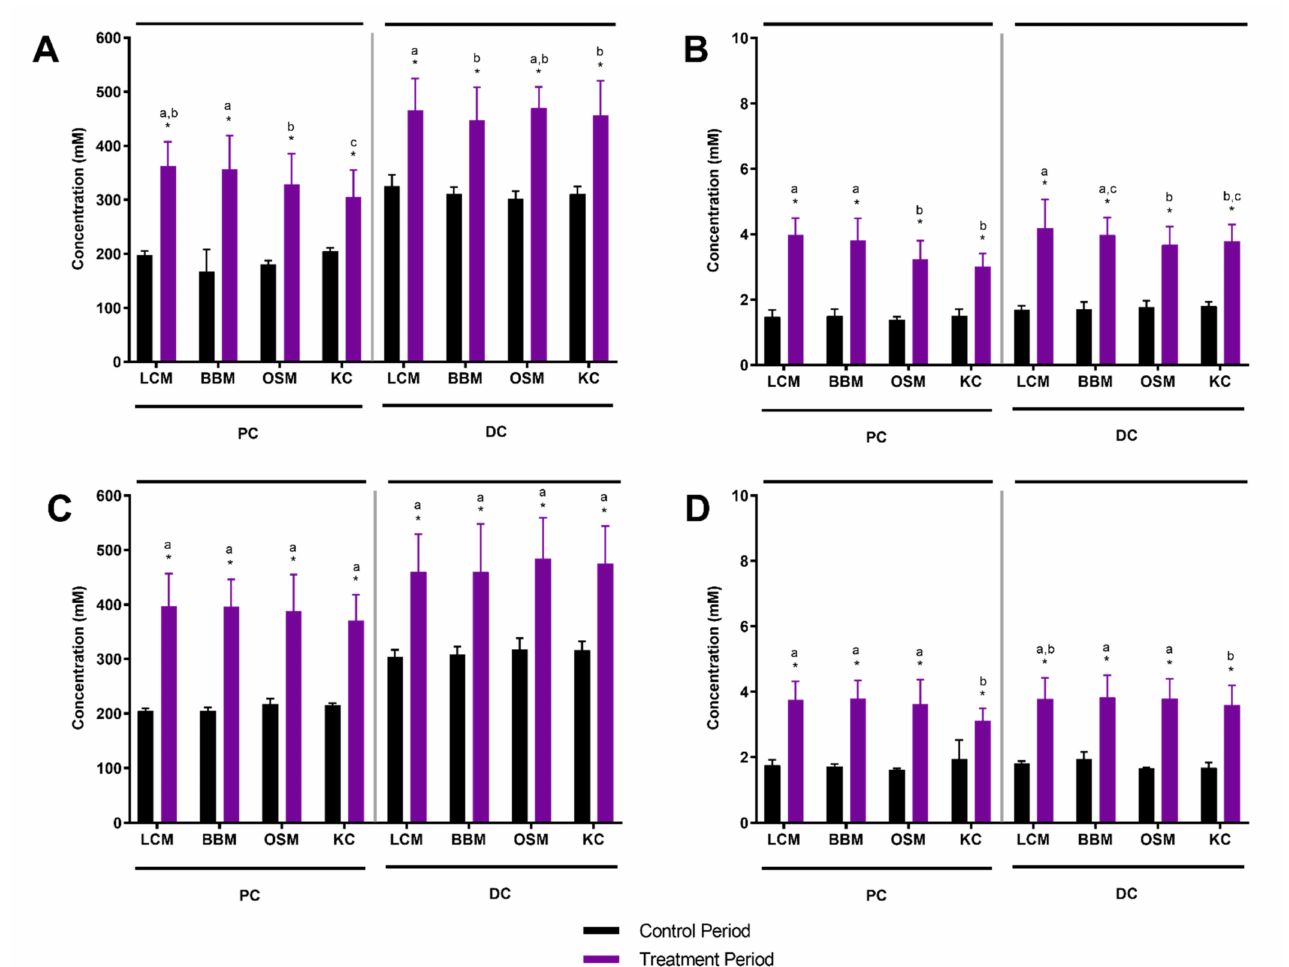
Figure 2. Changes in ammonium and bSCFA levels with treatment for ( A ) Donor A, ammonium; ( B ) Donor A, bSCFA; ( C ) Donor B, ammonium; ( D ) Donor B, bSCFA. * Indicates statistically significant differences relative to the control period while different letters indicate a statistical difference between different treatments, i.e., different letters for different columns indicates that the values in the columns are statistically significantly different while those marked with the same letter are not; p < 0.05. BBM = Berry Blast Muffin; DC = distal colon; KC = Kodiak Cake; LCM = Lemon Chia Muffin; OSM = Oat Spice Mookie; PC = proximal